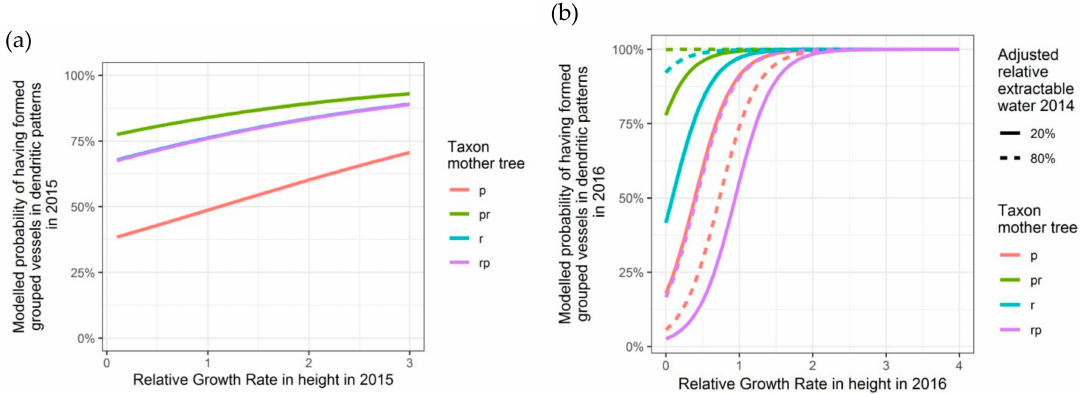
Figure 6. Modelled probability of having formed dendritic patterns (grouped vessels in flame-like structures) in the latewood xylem, depending on the relative growth rate in height, on the taxon of the mother tree and, only for 2016, on the adjusted relative extractable water in 2014: ( a ) second growing season 2015; ( b ) third growing season 2016. p: Q. petraea , pr: long stalked intermediate form, r: Q. robur , rp: short-stalked intermediate